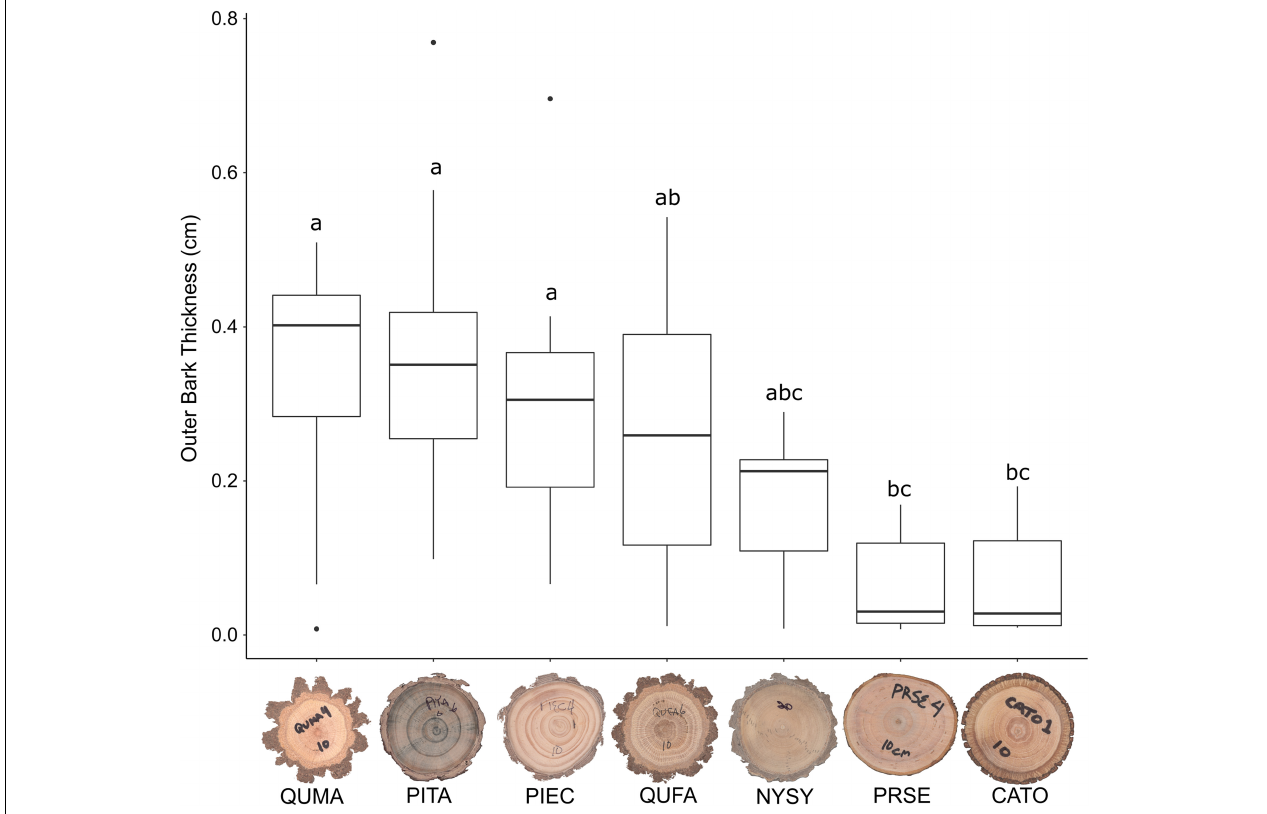
FIGURE 5 | Outer bark thickness (OBT) of basal cross-sections in seven co-occurring tree species. Species codes are as follows: QUMA, Quercus marilandica ; QUFA, Quercus falcata ; PIEC, Pinus echinata ; PITA, Pinus taeda ; NYSY, Nyssa sylvatica ; CATO, Carya tomentosa ; PRSE, Prunus serotina . Horizontal bar in each boxplot represents the median outer bark thickness. Species with the same letter are not statistically different at P =